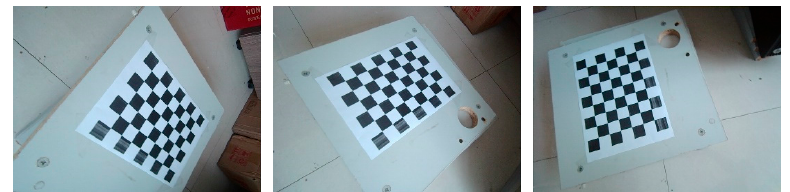
Figure 10. Chessboard image.